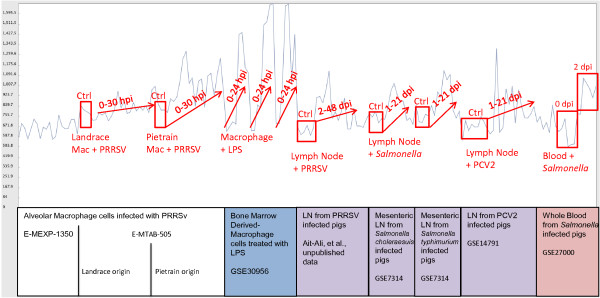
Expression pattern of MCL cluster 4 shows gene activation after immune stimulation/infection in multiple experimental datasets. In light blue is shown the average expression of the 619 probesets in cluster 4 from Figure 2. Details on each dataset are shown below the graph; some example patterns are highlighted in red; specific dataset patterns are boxed to show contrasts of interest. LN: lymph node; PRRSV: porcine respiratory and reproductive syndrome virus; PCV2: porcine circovirus type 2; Mac: alveolar macrophage; Ctrl: Control (uninfected) sample. Hpi: hours post infection or inoculation; Dpi: days post infection or inoculation. LPS: lipopolysaccharide.